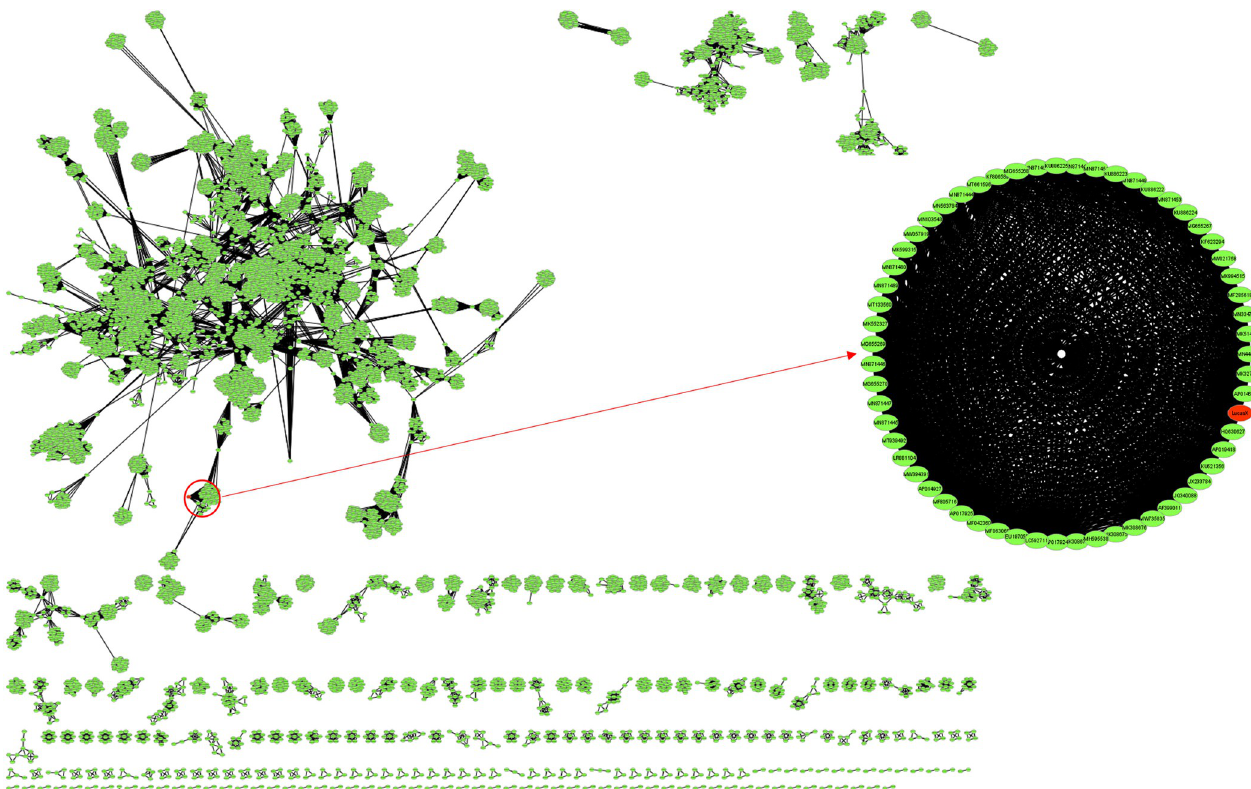
Fig 3. Network analysis based on proteome similarity made with vContact2 and visualized with Cytoscape (v3.8.2). LucasX annotated proteome was assigned to a novel viral cluster (cluster VC_312_0). A total of fifty-eight phages from the Myoviridae family were found to be connected to LucasX, as shown in detail, being that only one of them is not a Jumbo phage. LucasX phage is marked in